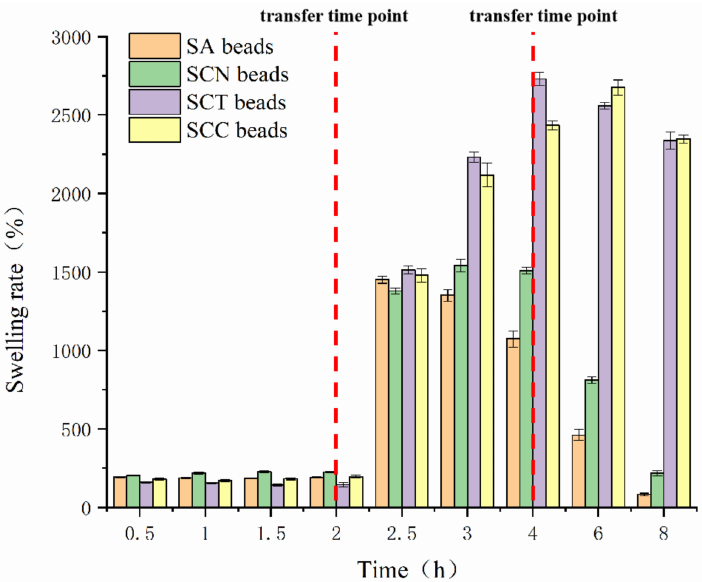
Figure 7. The effect of pH on the swelling rate of SA, SCN, SCT, and SCC